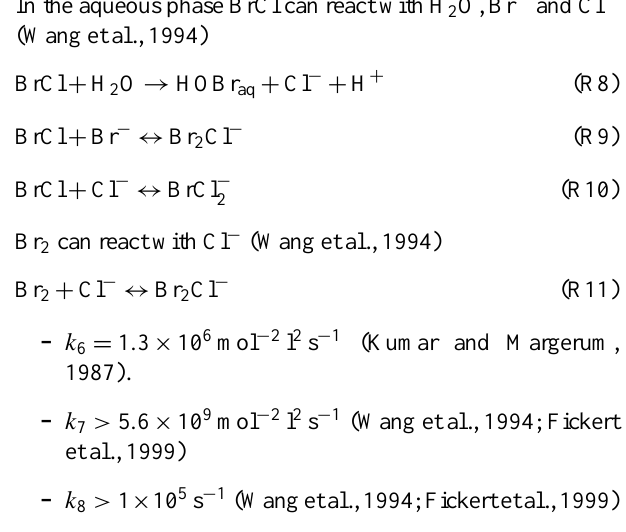
Fig. 11. Longitude-altitude cross section at 12.4 ◦ S of BrWMR for cloud pH = 5 in at t 0 + 110min in (a) CHBr 3 in the BG1 simulation, Figure 11: Longitude-altitude cross section at 12.4° S of BrWMR for cloud pH = 5 in at (b) CHBr 3 in the PERT1 simulation, (c) total PGs in the BG1 simulation, (d) total PGs in the PERT1 simulation. +110min in a) CHBr in the BG1 simulation, b) CHBr in the PERT1 simulation, c) total PGs in t 0 3 3 to a shorter mean lifetime for all organic PGs in the the BG1 simulation, d) total PGs in the PERT1 simulation.